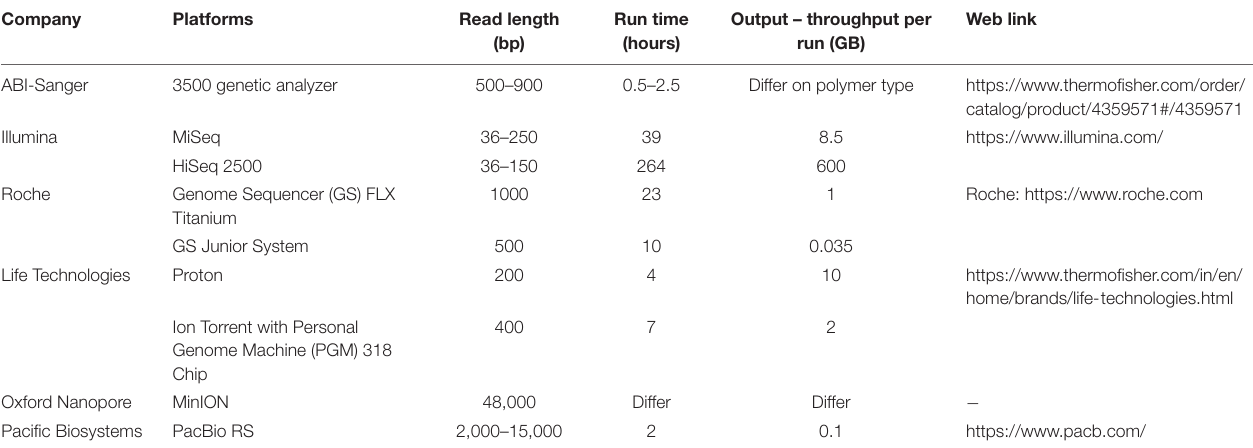
TABLE 1 | Different next-generation sequencing platforms used in metagenomics